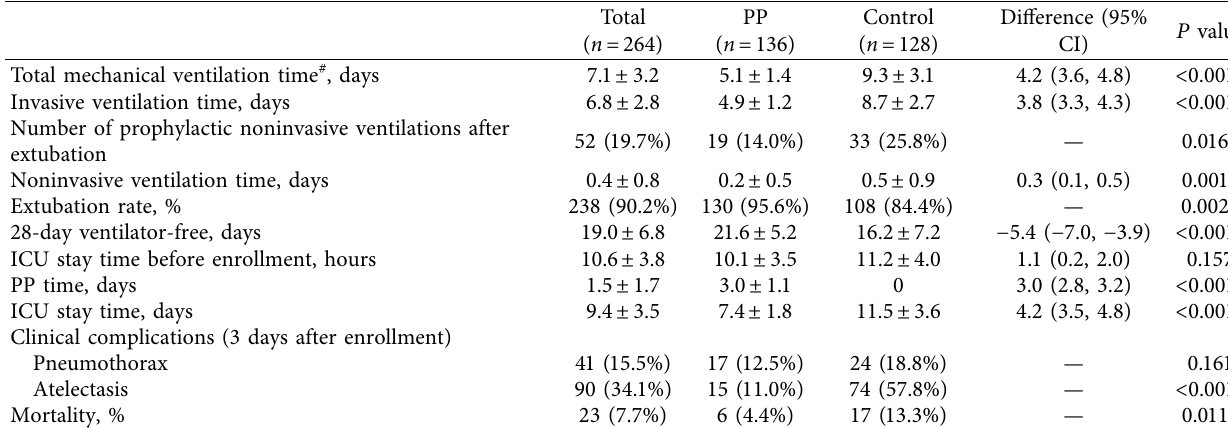
Table 4: Outcomes of mechanical ventilation, ICU stay, clinical complications, and